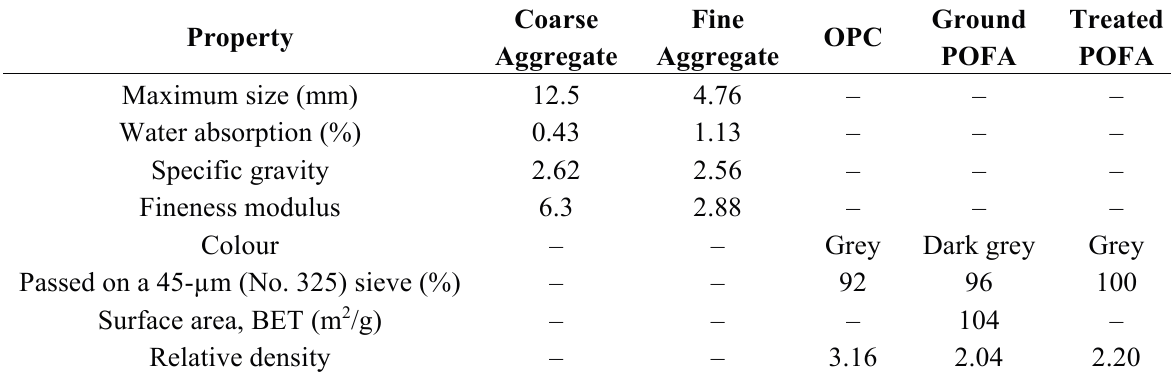
Passed on a 45-µm (No. 325) sieve (%)